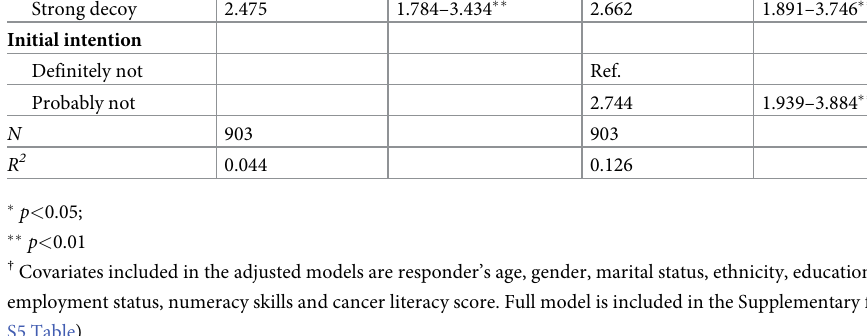
Table 3. Logistic regression models on hospital choice in Study 2. Condition